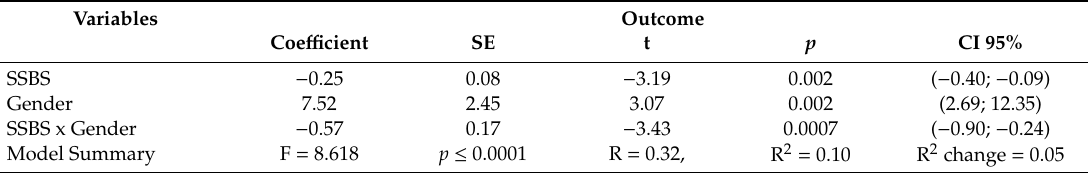
Table 3. Simple moderation e ff ect of gender on the link between School Burnout and Internet Addiction.